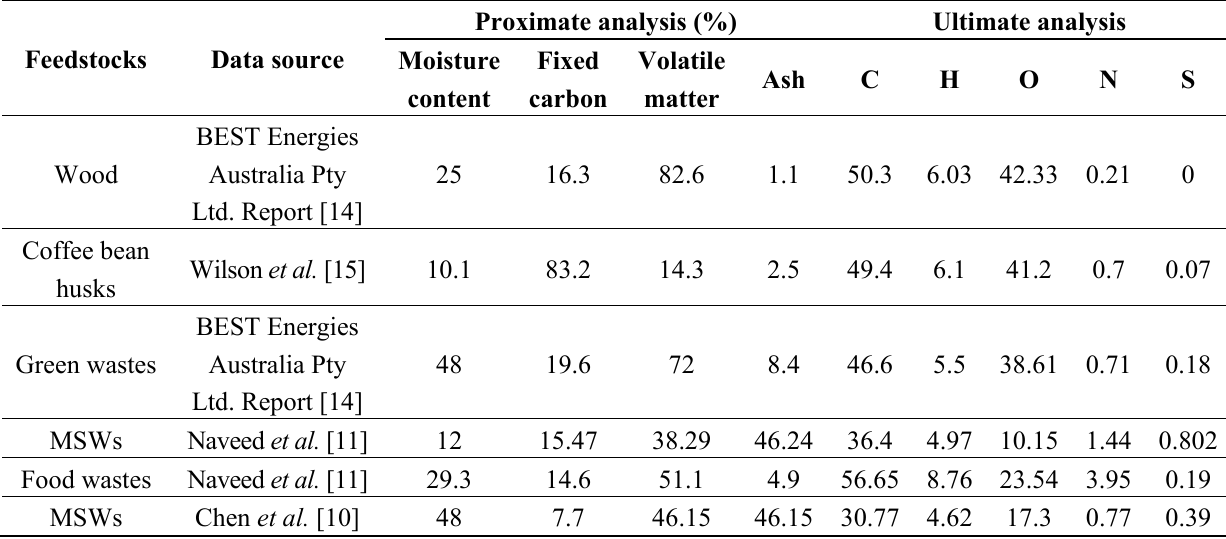
Table 1. Characteristics of feedstocks.